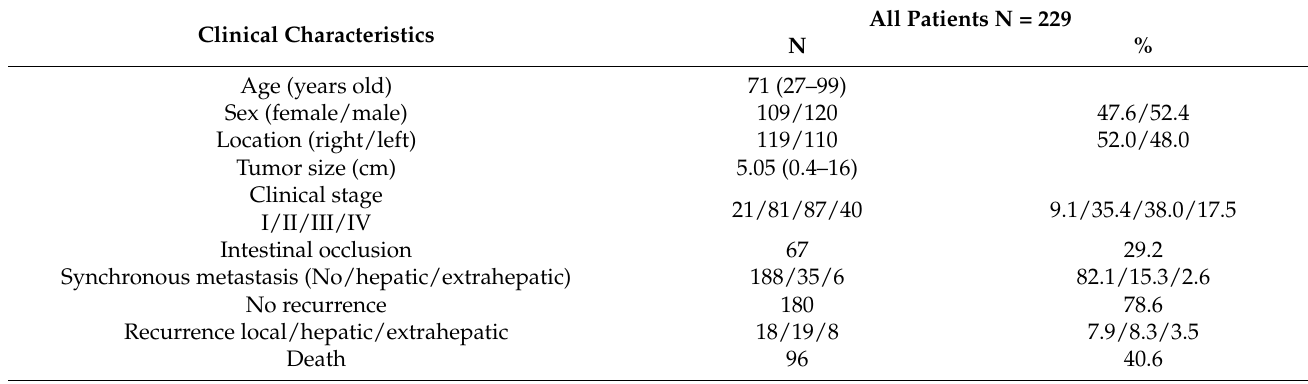
Table 1. Clinical characteristics of the